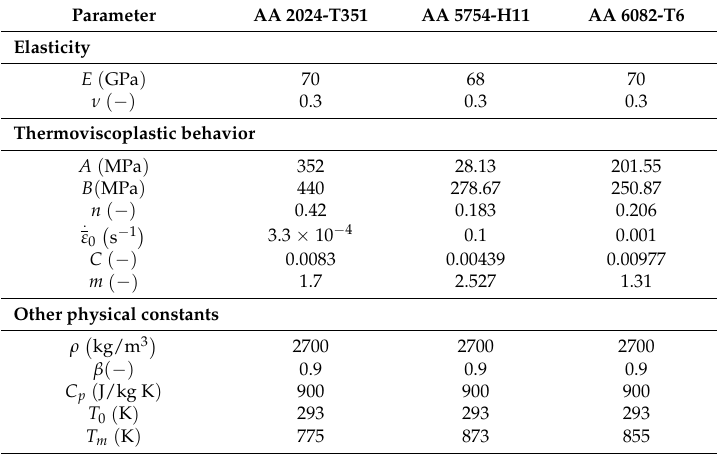
Table 2. Material properties and Johnson–Cook parameters of aluminum